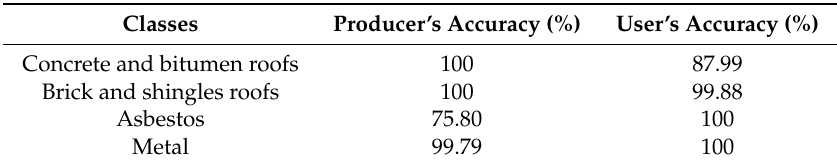
Table 4. ROI-based SAM classification accuracy of building roof categories. Producer’s Accuracy (%) and User’s Accuracy